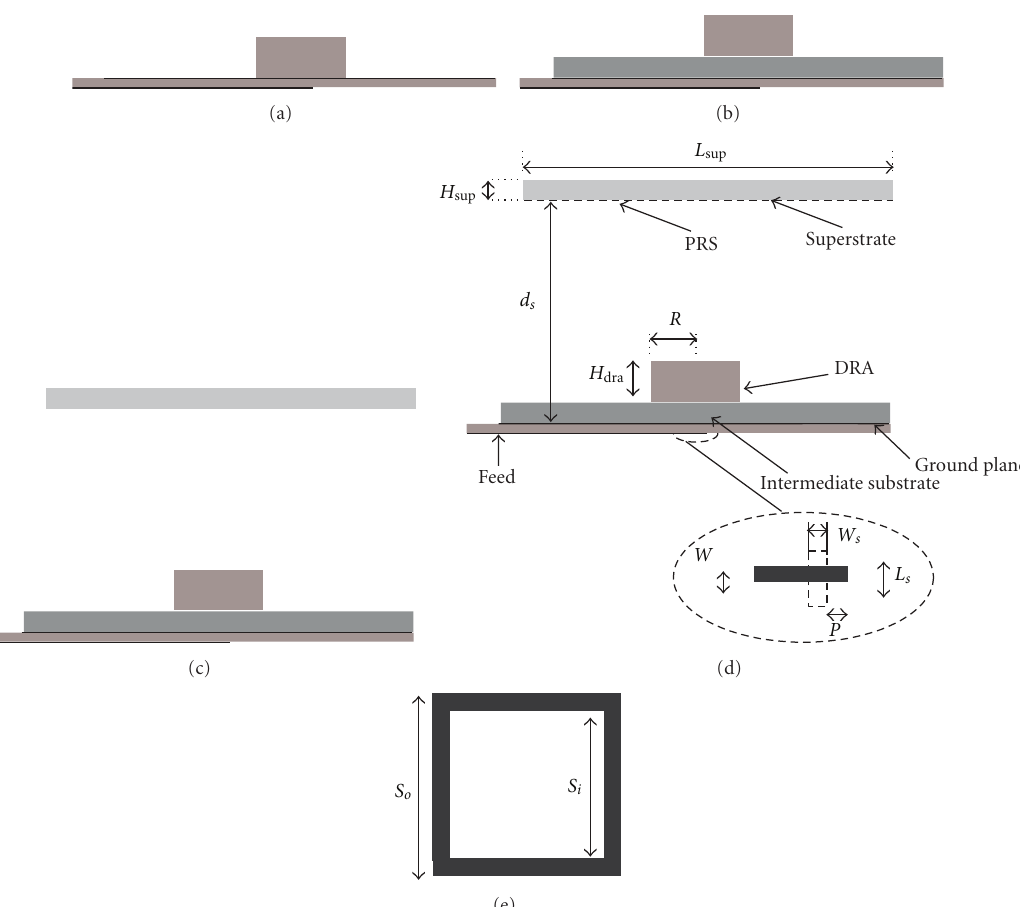
Figure 1: (a) Antenna 1, (b) antenna 2, (c) antenna 3, (d) FPC fed by a DRA, and (e) unit cell of the square ring FSS.